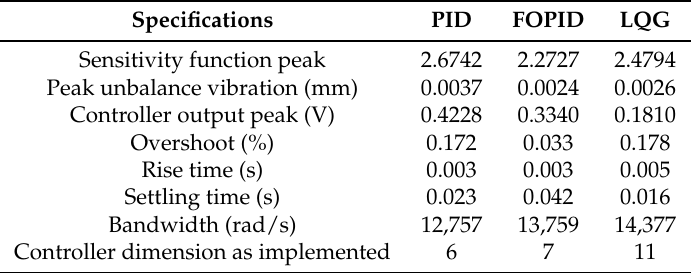
Table 6. Comparison of performances in radial AMBs.